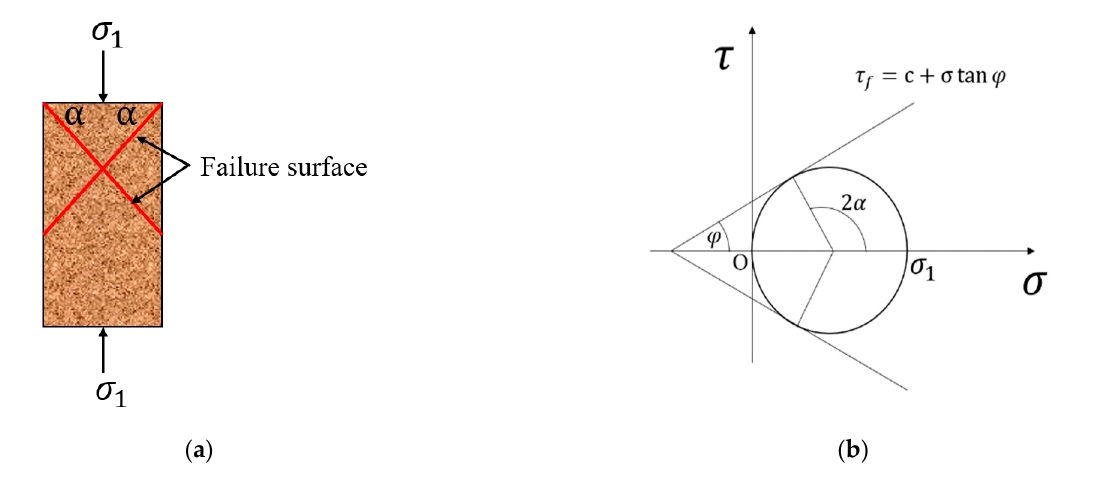
Figure 11. The location of the shear failure surface in the soil. ( a ) Location of the failure surface, ( b ) The destruction Mohr circle and strength wrapping wire. ( b ) The destruction Mohr circle and strength wrapping